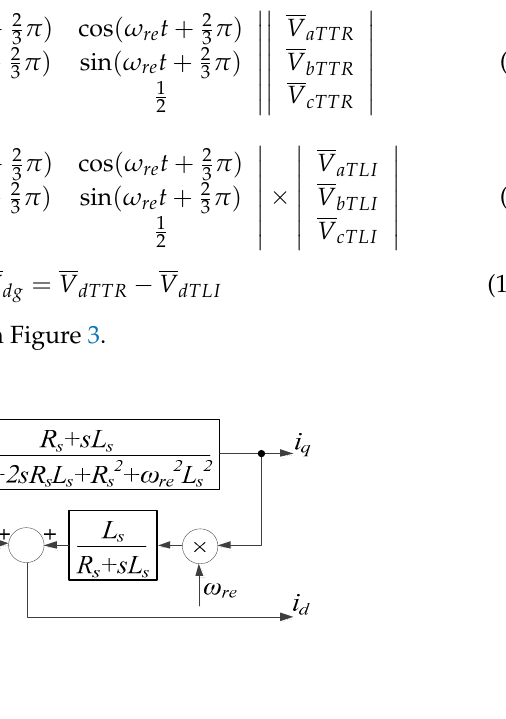
Figure 3. Block scheme of the permanent magnet synchronous generator (PMSG) model.